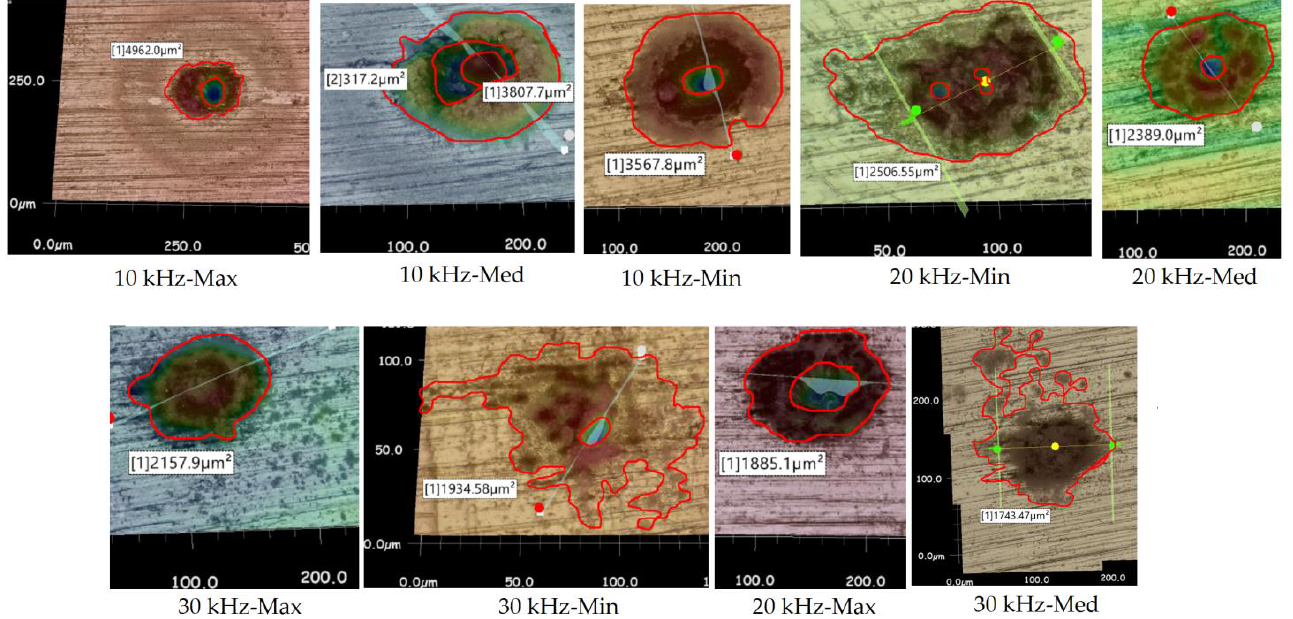
Figure 8. 2D microscope profiles (from highest RFP 2 , 10 kHz-Max, to the lowest, 30 kHz-Med).